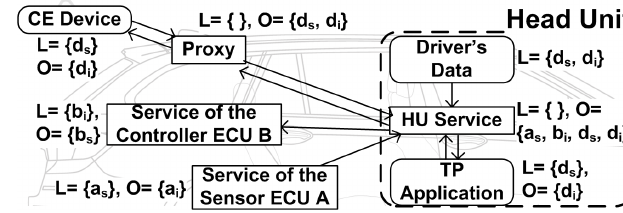
Figure 8. Security scenario. Rectangular boxes represent services running on an independent IFC aware middleware. Round boxes represent IFC unaware applications, devices and files. Solid arrows represent middleware-based